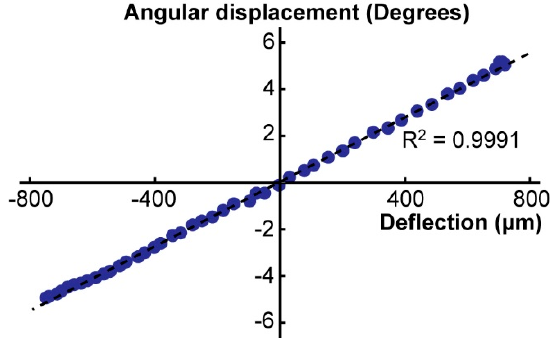
Figure 8. The above graph displays the angular displacement (degrees) of the tweezer tips plotted against the corresponding piezoplate displacement (m). against the corresponding piezoplate displacement